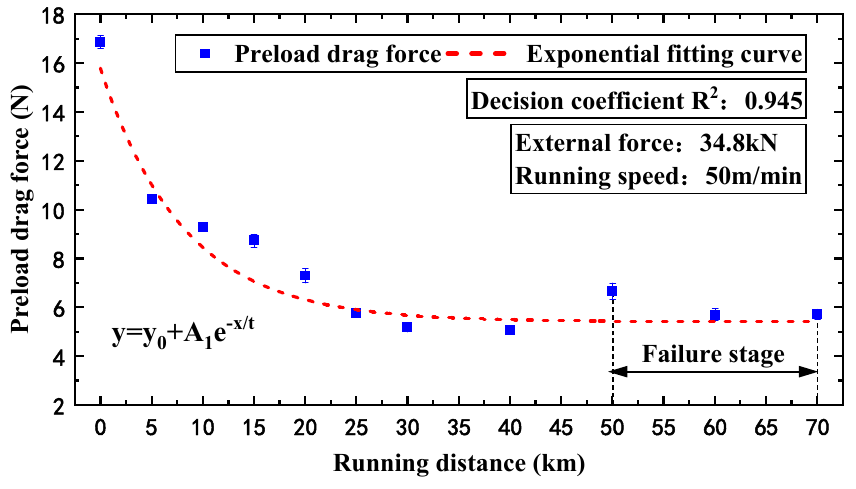
Figure 7. Preload drag force degradation curve.